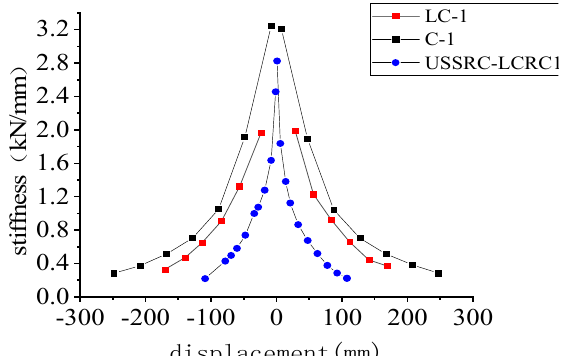
Figure 16. Comparison of stiffness degradation curves of the three types of column connection components.